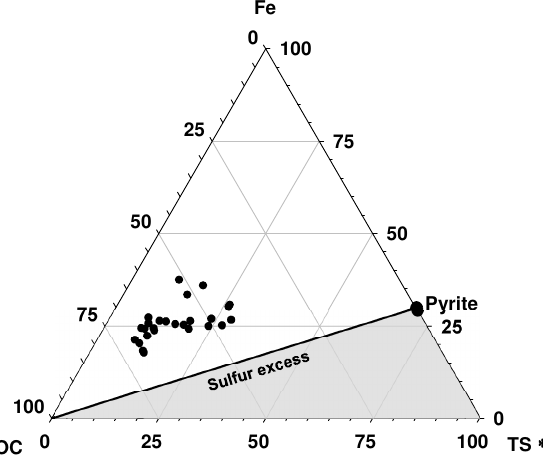
Figure 7 Ternary plot of carbon–iron–sulfur relationship. The shaded area represents the field Fig. 7. Ternary plot of carbon-iron-sulfur relationship. The shaded where iron is limiting. Sulfur was multiplied by 2 (2 moles of C produce 1 mole of S). Iron was area represents the field where iron is limiting. Sulfur was multi- determined from solid extraction with HCl. Data are from stations A and K. plied by 2 (2 moles of C produce 1 mole of S). Iron was determined from solid extraction with HCl. Data are from stations A and